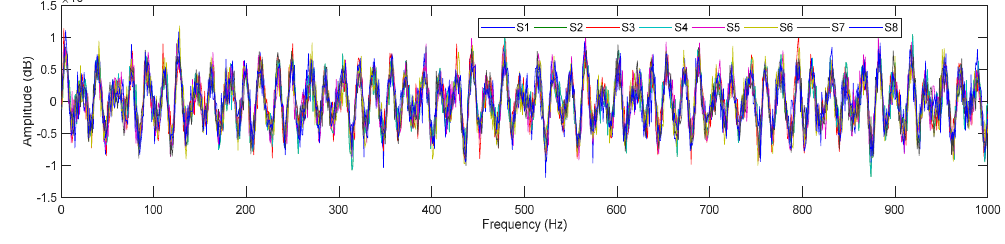
Figure 7. All RFID tags’ merged signals.